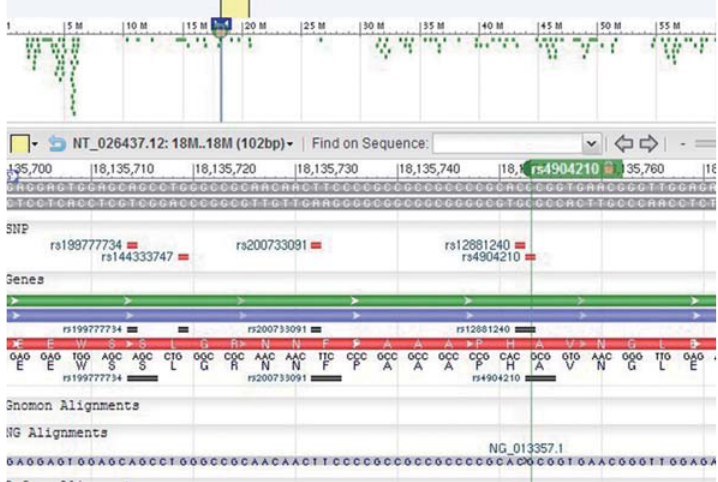
Figure 9- The gene chromatograms of c.718G>C (rs4904210) single nucleotide polymorphisms (SNPs) in